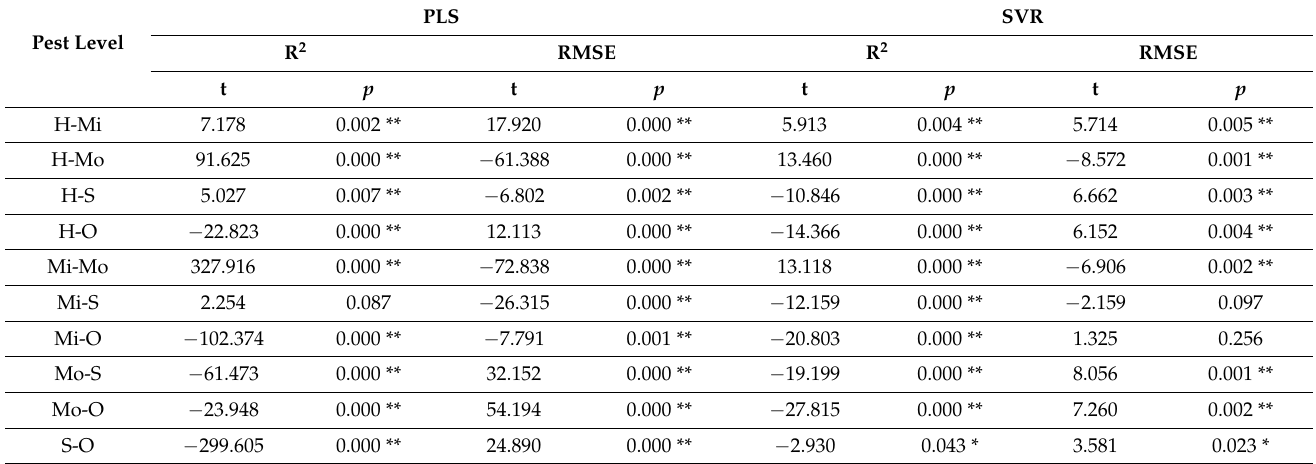
Table 2. Paired t -test for evaluation index of PLS and SVR